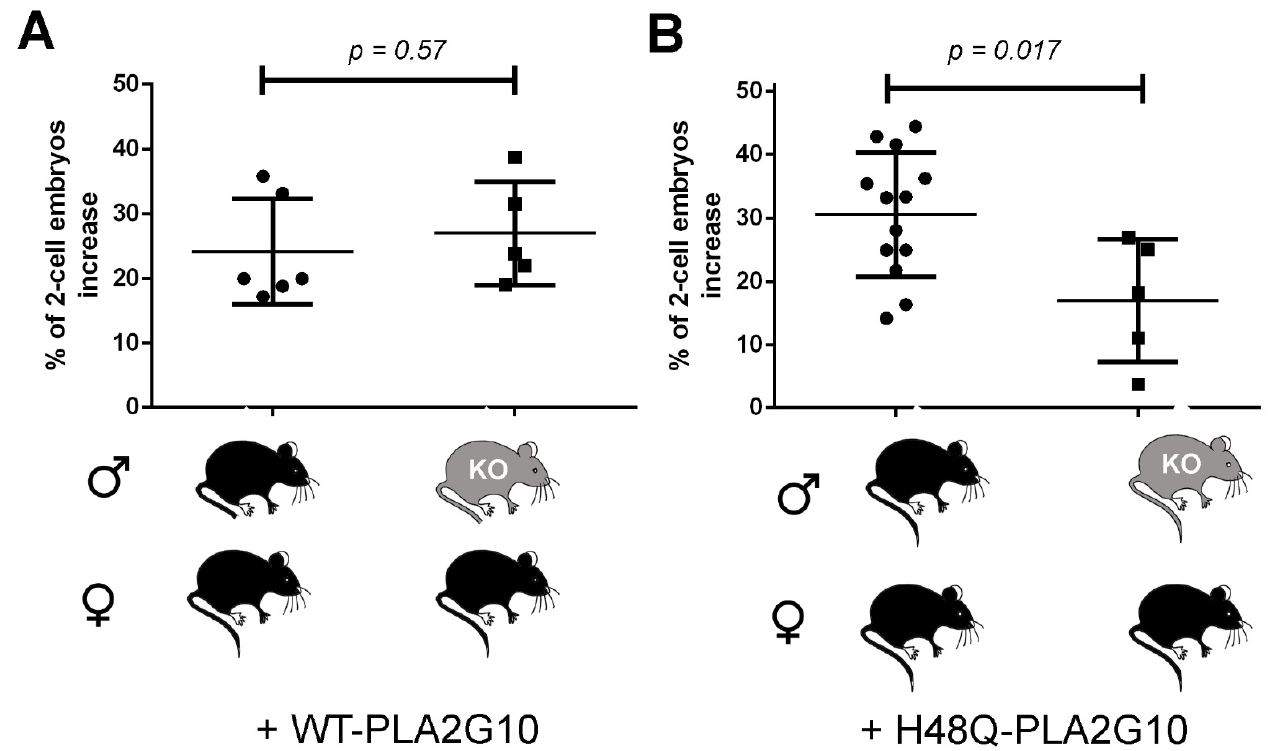
Figure 9. IVF efficiencies are similarly improved when sperm from C57BL/6 and Pla2r1 -KO males are treated by WT-PLA2G10 in contrast to what is observed in sperm from C57BL/6 and Pla2r1 -KO males treated by H48Q-PLA2G10. ( A ) Comparison of the % of improvement of 2-cell embryos generated with 200 nM WT-PLA2G10-treated sperm from C57BL/6 or Pla2r1 -KO males and oocytes from C57BL/6 females as indicated. ( B ) Comparison of the % of improvement of 2-cell embryos generated with 200 nM H48Q-PLA2G10-treated sperm from C57BL/6 or Pla2r1 -KO males and oocytes from C57BL/6 females, as indicated. Statistical comparisons were made with the t -test.